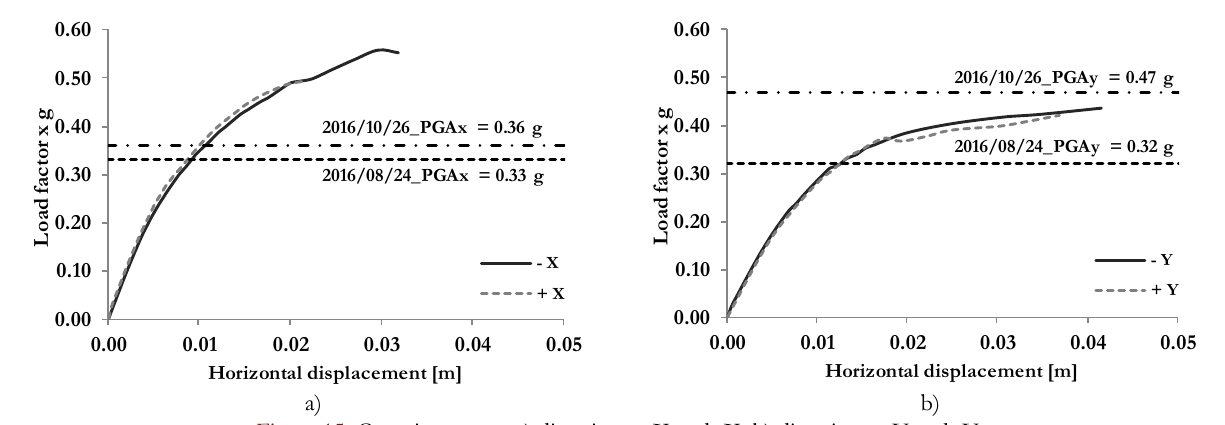
Figure 15: Capacity curves: a) directions +X and -X, b) directions +Y and